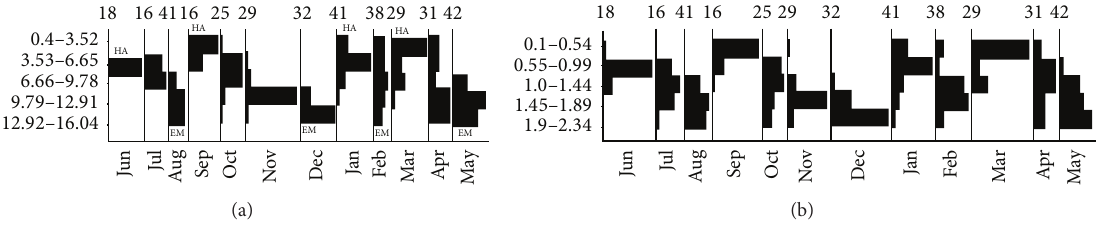
Figure 2: Size frequency distribution of L. nuburagangai , (a) body length (mm), and (b) head width (mm) (HA—hatching; EM—emergence).